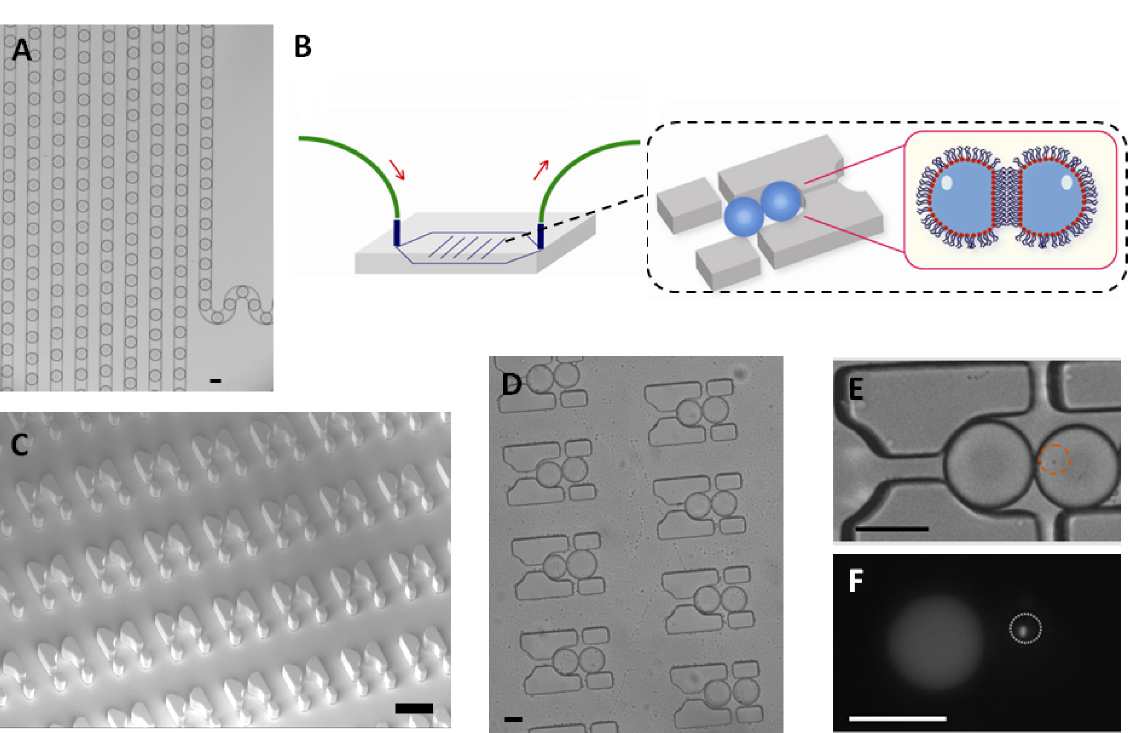
Figure 1. Experimental setup. ( A ) Generation of a monodisperse emulsion with a microfluidic droplet production device. Aqueous droplets (65 picoliter) containing a single bacterium or signaling molecules were generated in fluorinated oil using a flow-focusing configuration; ( B ) Illustration of the injection of a prepared emulsion into the trapping device. Double droplet pairs were confined in traps where a droplet interface bilayer formed between droplets; ( C ) The scanning electronic microscopy (SEM) image of arrayed traps in the trapping device, which was fabricated using the standard soft lithography [16]; ( D ) Double droplets were trapped in the microfluidic device; ( E ) The bright field image of the two trapped droplets. The left droplet contained rhodamine B isothiocyanate-dextran labeled microbeads (500 nM) with 10 µM OdDHL, and the right droplet encapsulated LasR-expressing E. coli (indicated by the orange circle) which contained a plasmid (pSB1014) that caused constitutive expression of red fluorescent protein (RFP) in the presence of arabinose; ( F ) The red fluorescence image showed the LasR-expressing E. coli (indicated by the white circle) due to the expressed RFP. The construction of plasmid followed the previous work [17,18]. Bar scales: ( C ) 60 µm, ( D ) 40 µm, ( E , F ) 50